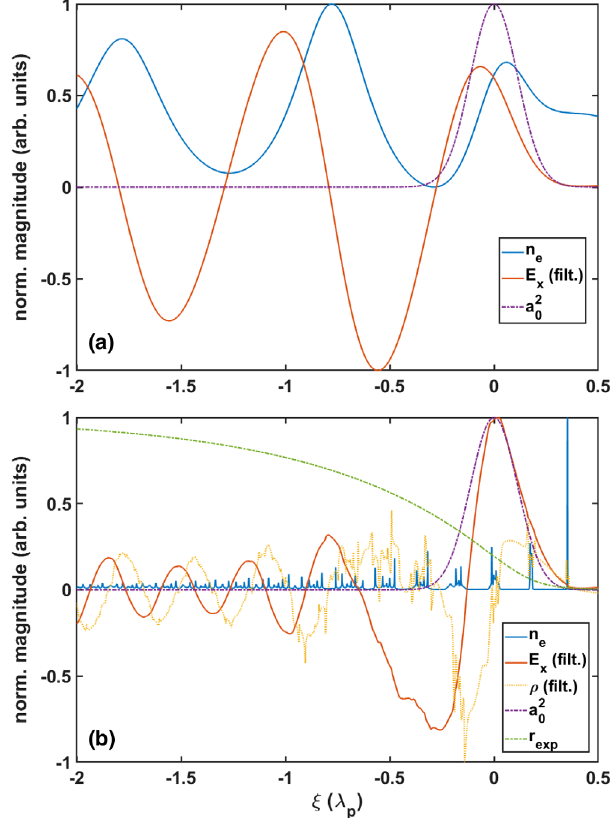
FIG. 3. Results of the 1D model of a wakefield in a co-moving frame showing the difference in wavelength of the smoothed longitudinal electric field E for two different cases. The top x panel shows a reference solution for a wakefield in a uniform plasma of background density n 0 ¼ 0 . 001 × n and the ξ -axis crit ð n Þ =c . The bottom panel shows a plasma of is normalized to ω 0 p , in which clusters of background density n 0 ¼ 0 . 001 × n crit density 1 . 5 × n are injected from the right boundary. They crit artificially expand according to the expansion function r . The exp ¼ 0 . 0081 × n leading to a predicted average density is n av crit plasma wavelength of 8 . 9 μ m. The electric field was smoothed using a Gaussian smoothing